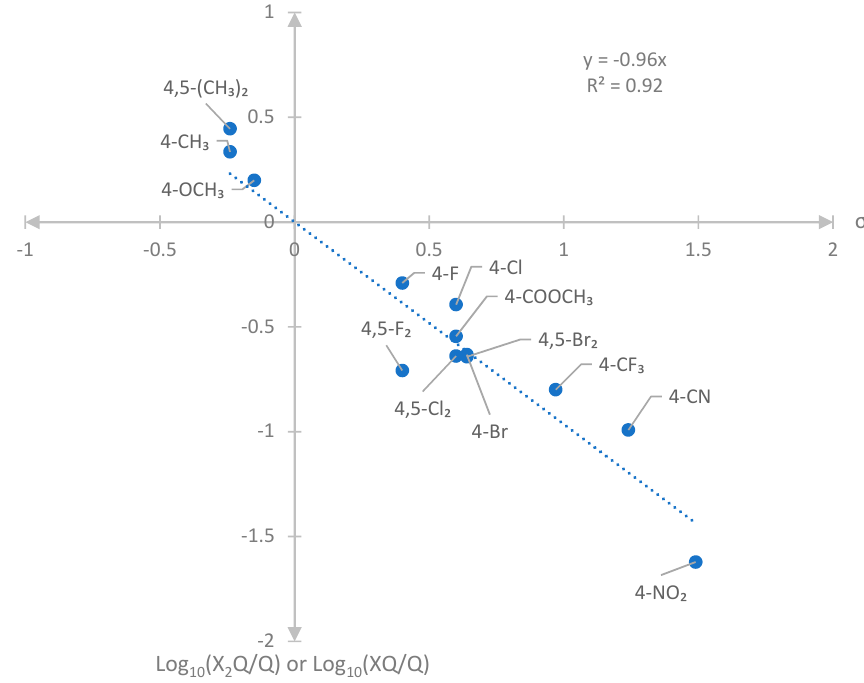
Figure 1. Hammett plot of XQ/Q or X 2 Q/Q ratio with standard composite σ constants.